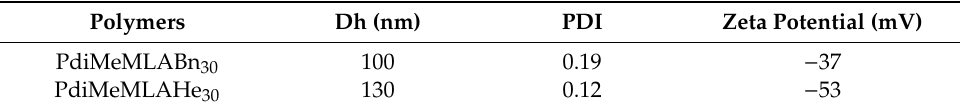
Table 4. Characteristics of NPs suspensions prepared from PdiMeMLABn 30 and PdiMeMLAHe 30 .